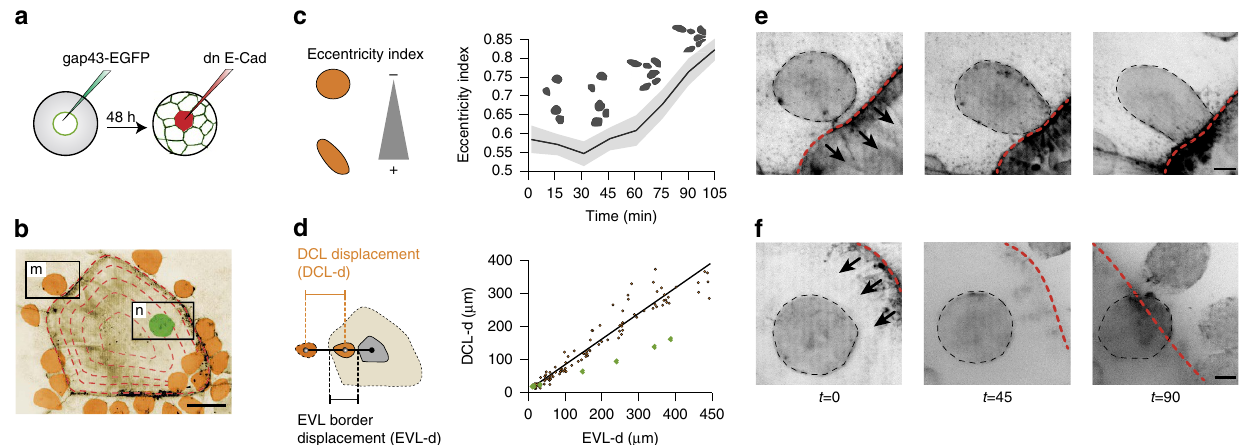
Figure 4 | Traction forces exerted by the EVL on the DCL. ( a ) Schematic diagram of the method used to induce EVL apical extrusion by overexpressing dn E-cad in a single EVL cell (red) in an A. nigripinnis embryo expressing GAP43-EGFP . ( b ) Confocal microscopy z-stack maximum projection centred in a EVL cell manipulated as in a at the onset of apical extrusion (time ¼ 0). During the following 105min, the EVL cell progressively contracts and reduces its surface area (dashed orange lines). The image look-up table has been inverted, the EVL pseudocoloured in light brown and DCL cells coloured according to their position: in the periphery (orange) and under (green) the extruding EVL cell. ( c ) Quantification of the eccentricity index for the DCL cells shown in ( b ), revealing cell elongation during EVL cell extrusion. Values are expressed as means ± s.e.m. ( n ¼ 20 cells). Examples of DCL cells at 4 time points are given above the curve. ( d ) Correlation between the displacement of the DCL centre of mass and the EVL cell border from time 0 to 105 for all DCL cells labelled in orange in b ( n ¼ 20 cells), showing the changes in DCL position with respect to the border contraction of the extruding EVL cell. Green dots indicate the changes in position for the green cell shown in b . ( e , f ) Time series of confocal microscopy z -stack maximum projections of two DCL cells selected from b , showing the changes in cell shape and position with respect to the border contraction of the extruding EVL cell. In e , the DCL is positioned in the periphery of the extruding EVL cell under a wild type EVL (with normal E-cad function). In f , the DCL is positioned under the extruding EVL cell (with impaired E-cad function). Arrows indicate the movement direction of the contracting border of the extruding EVL cell (dashed red line). Time is in minutes. Images and plots were extracted from Supplementary Movie 2. Scale bar, 10 m m ( e , f ) and 50 m m ( b